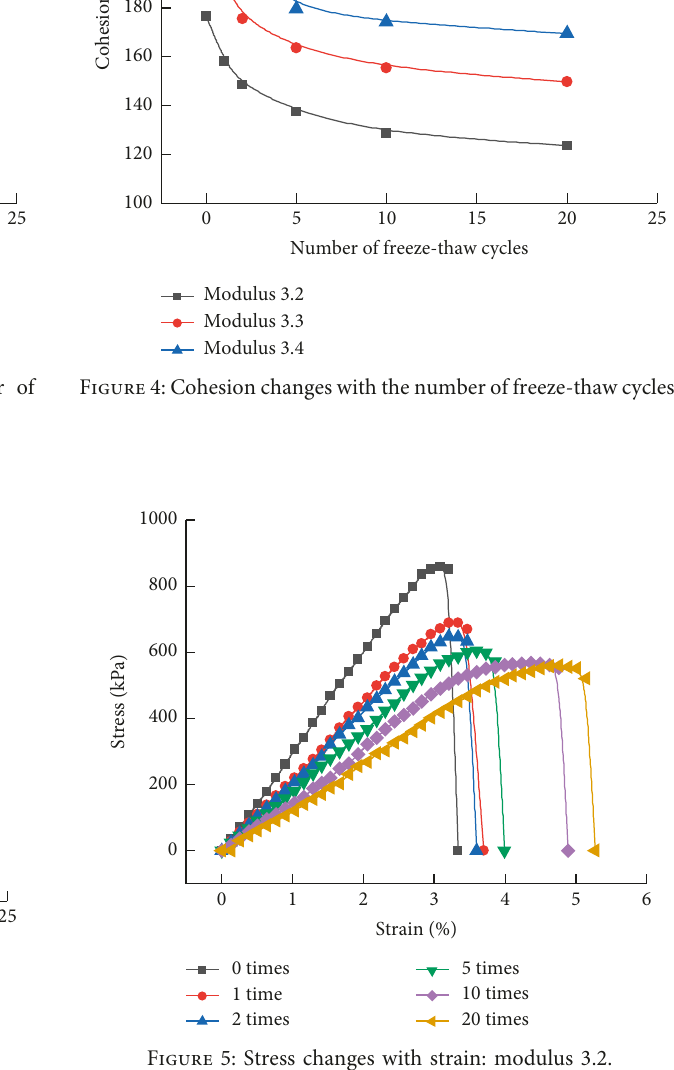
Figure 3: Internal friction angle changes with the number of freeze-thaw cycles.